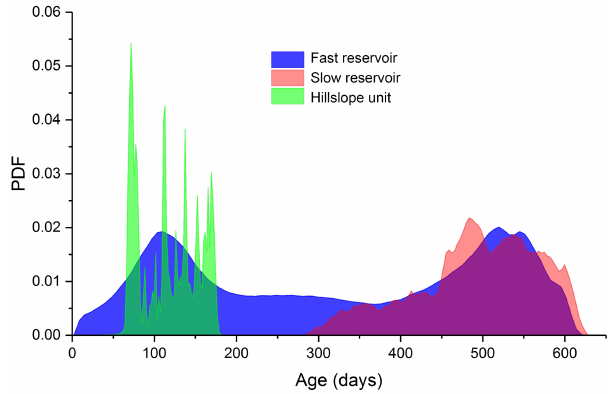
Figure 11. Probability density functions of the simulated water ages for the best 500 runs in fluxes for all three